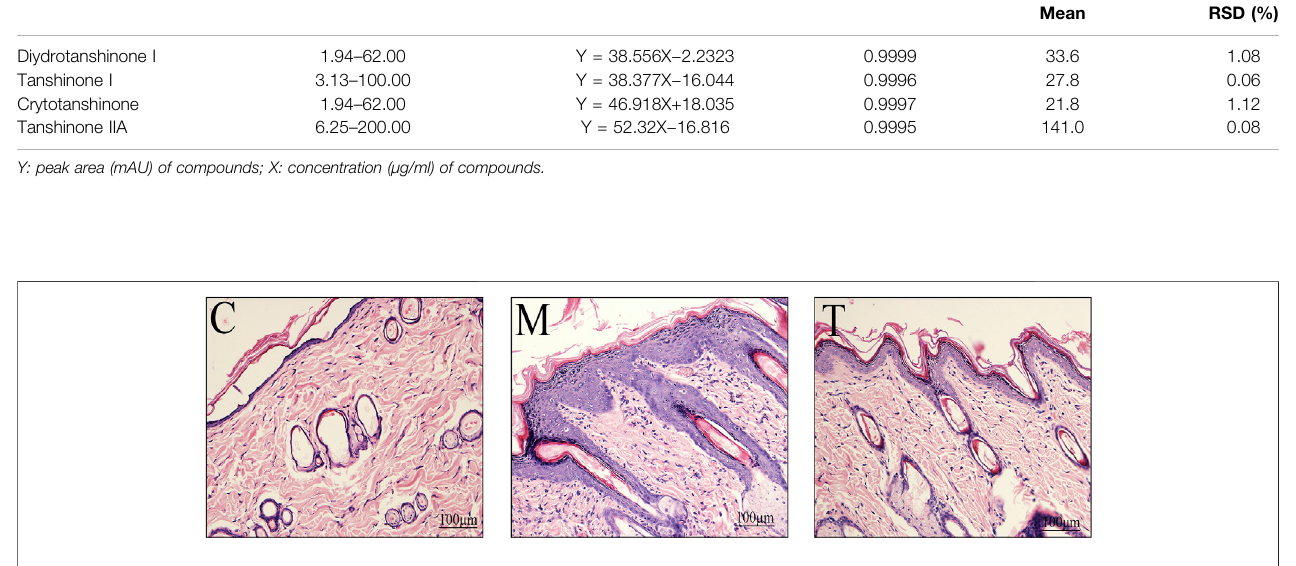
Figure 6C (R 2 X (cid:1) 0.609, R 2 Y (cid:1) 0.964, Q 2 (cid:1) 0.924) and Figure 6D (R 2 X (cid:1) 0.670, R 2 Y (cid:1) 0.986, Q 2 (cid:1) 0.895). Permutation testing and cross validation support this fi nding ( Figure 6 ). Table 2 lists the signi fi cantly different lipids.